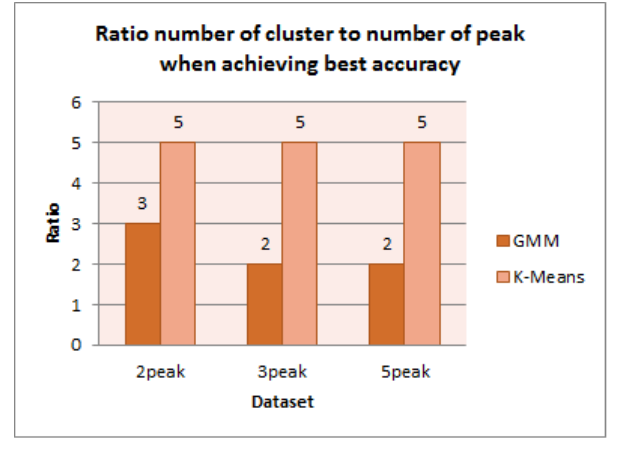
Figure 11. Best Number of Cluster.